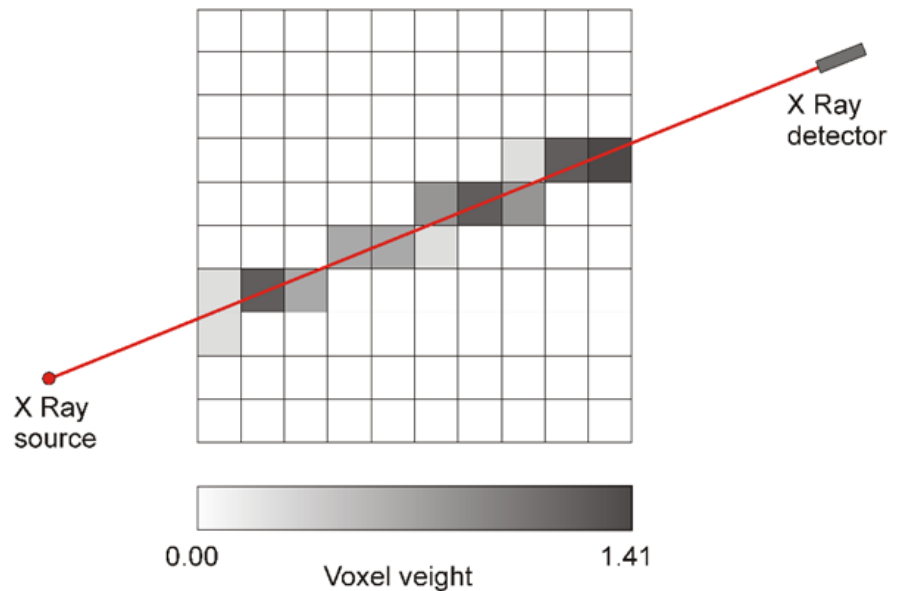
Figure 2. The simplified geometry of projects acquisition. The grey nuances can be correlated with the length of X-ray beam through each